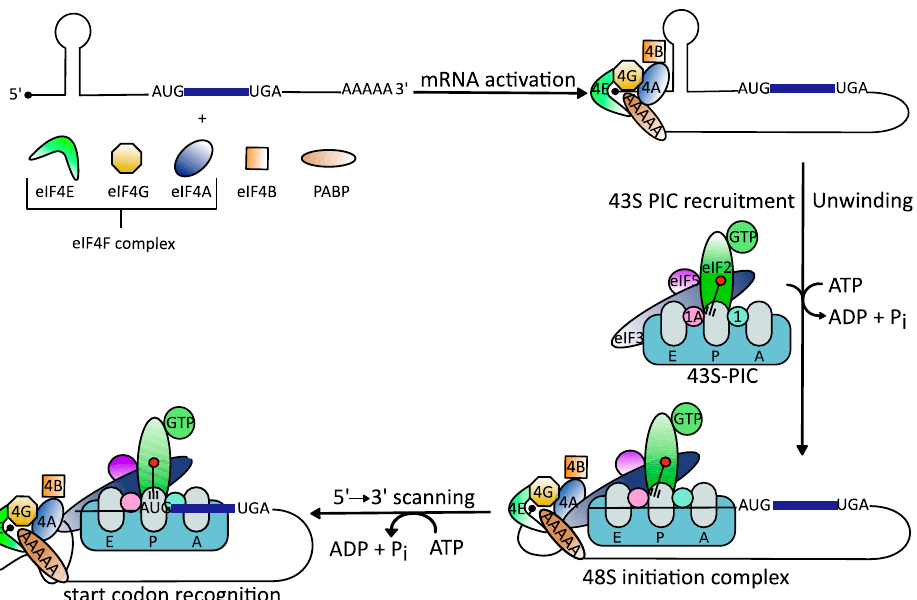
Figure 1. Schematic illustration of the eukaryotic translation initiation mechanism (modified from [38]). Binding of the heterotrimeric eIF4F complex to the 5 ′ cap structure of mRNAs is followed by unwinding of stable RNA secondary structures by the DEAD-box RNA helicase eIF4A. This enables binding of the 43S preinitiation complex (PIC), which scans down the 5 ′ -untranslated regions (5 ′ UTRs) to identify the start codon AUG.